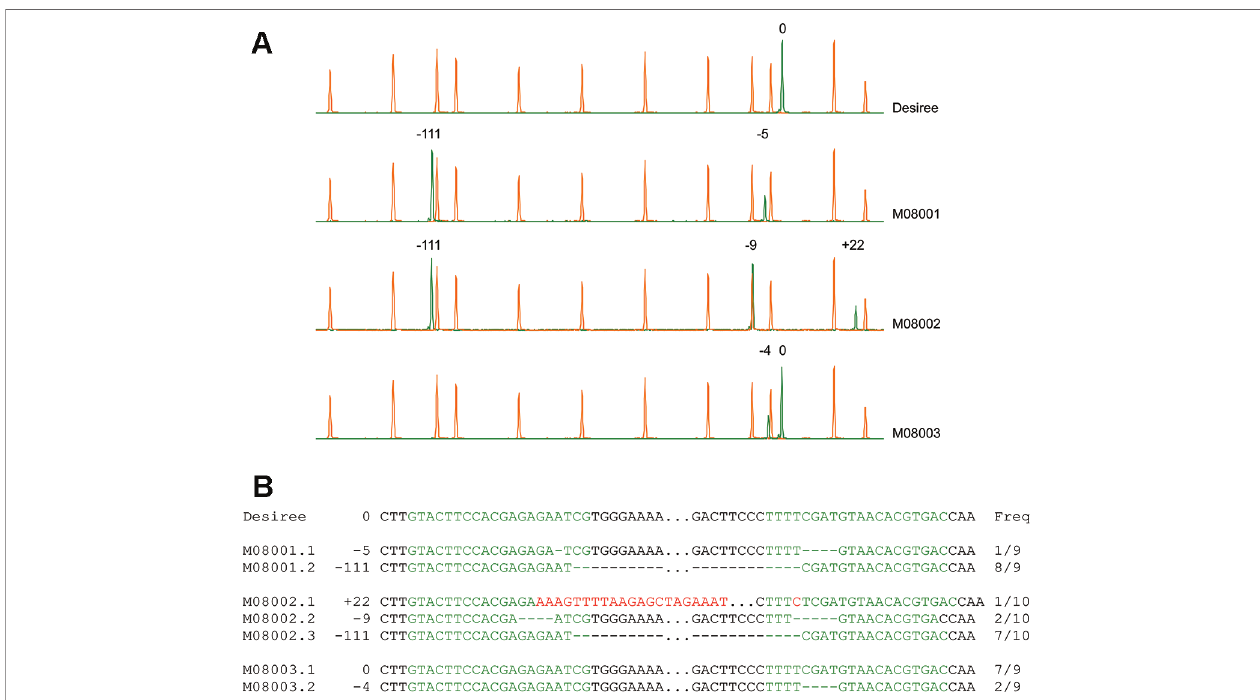
FIGURE 2 | Identi fi cation of edited lines using High Resolution Fragment Analysis (HRFA) and characterization of mutations by sequencing (A) Electropherograms of HRFA obtained for wild type Desiree and lines M08001, M08002, and M08003. The orange peaks correspond to the elution points of the size standard and green peaks correspond to elution of the StPPO2 gene fragments. The elution of the wild type fragment is set to 0 and the number of bases inserted (+) or deleted ( − ) in each fragment is indicated above the respective peak (B) Sequencing of a partial fragment of the StPPO2 alleles in selected lines. Target sites for the sgRNAs are marked in green letters. Deleted nucleotides are indicated as hyphens and inserted bases are marked in red letters. The frequencies obtained during Sanger analysis are indicated, as the number of clones carrying each allelic variant related to the total number of sequenced